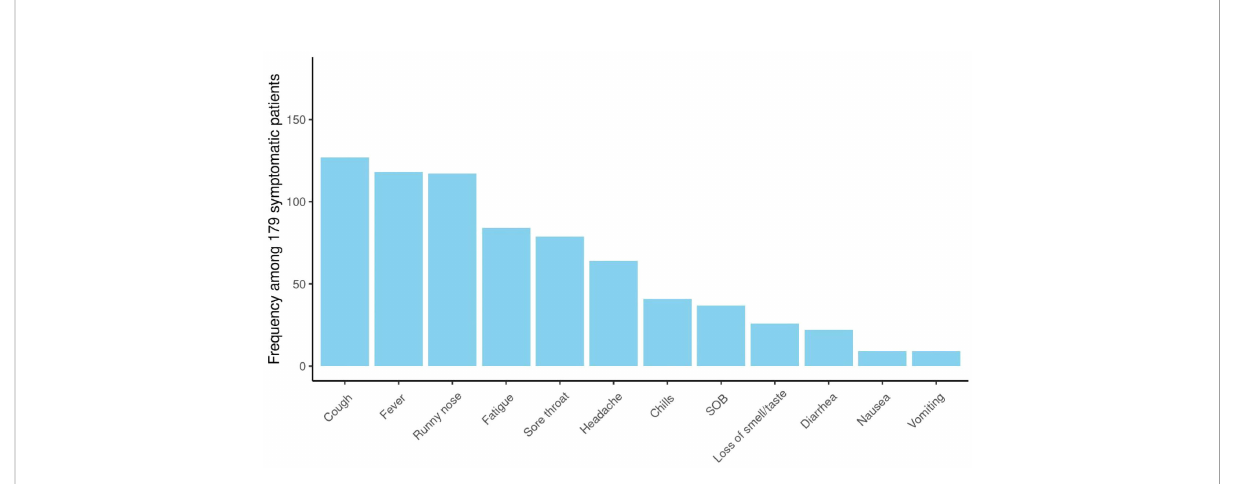
FIGURE 2 Symptomatology of COVID-19 infection: Among patients with COVID-19 infection (n= 263); 179 patients were symptomatic. The most commonly reported symptoms at presentation were cough (n=127, 71%), fever (n=118, 66%), runny nose (n=117, 65%).